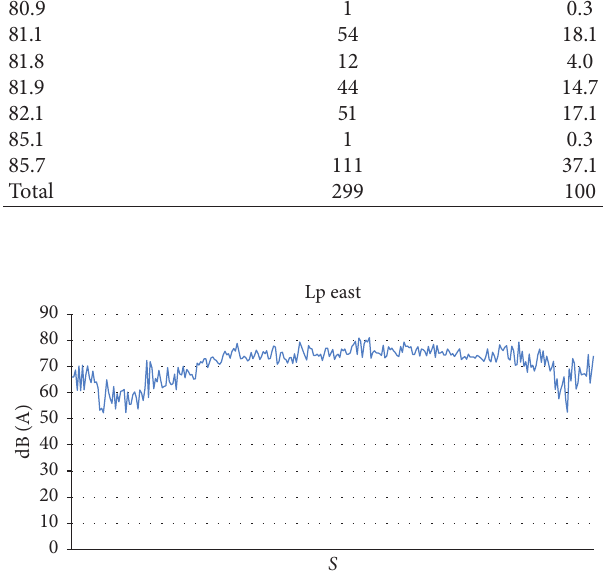
Figure 3: Sound level Lp east of the practical classroom.